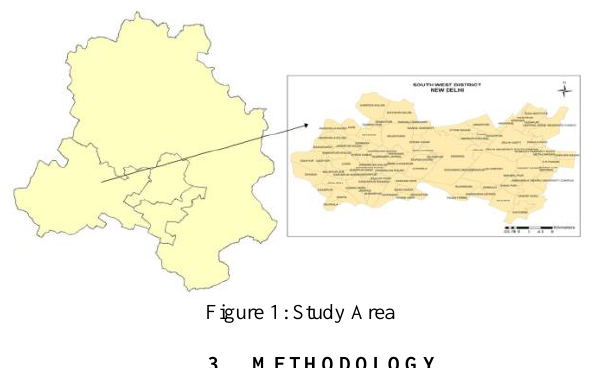
Figure 1: Study Area